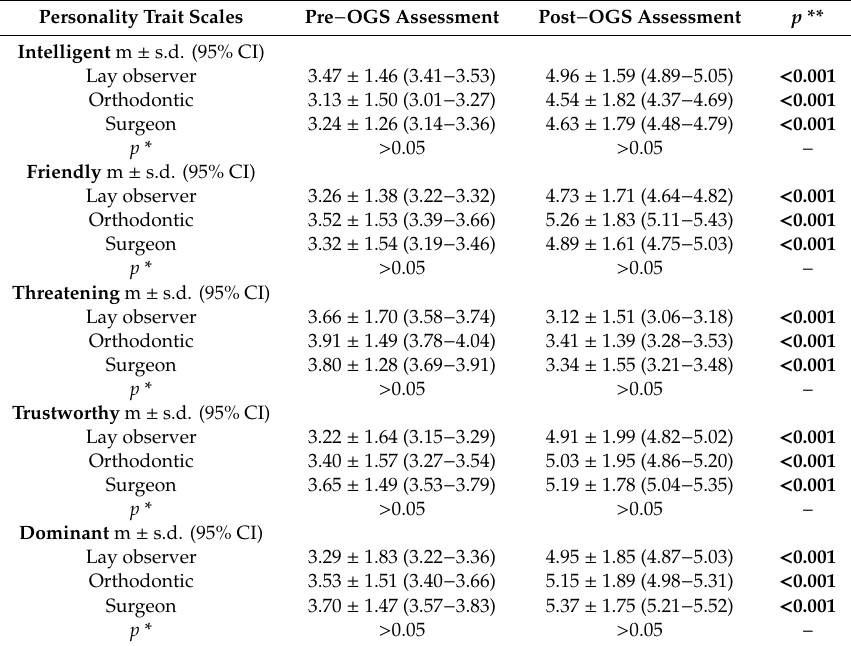
Bold values indicate statistical significance after Bonferroni correction. OGS, orthognathic surgery; m, mean; s.d., standard deviation; CI, confidence interval; p , p − value; –, not applicable; *, comparisons among the groups of raters; **, pre − OGS versus post − OGS scores comparisons. Table 4. Panel assessment of emotional expressions.